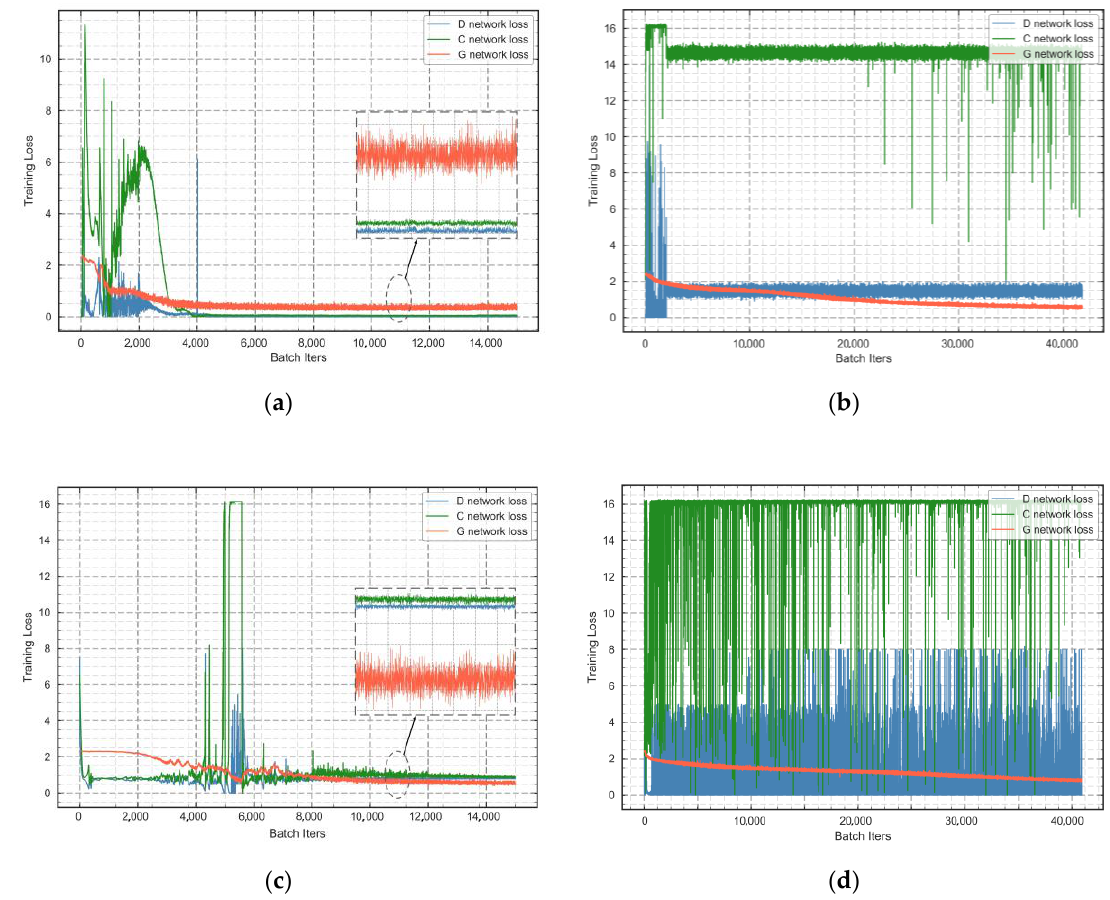
Figure 4. Loss convergence with regard to training epochs for various frameworks: ( a ) SCGAN; ( b ) SCGAN without SSTM; ( c ) ACGAN with SSTM; ( d ) ACGAN without SSTM.